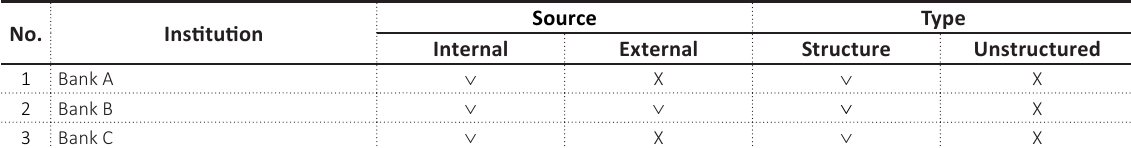
Table 4. Source and type of